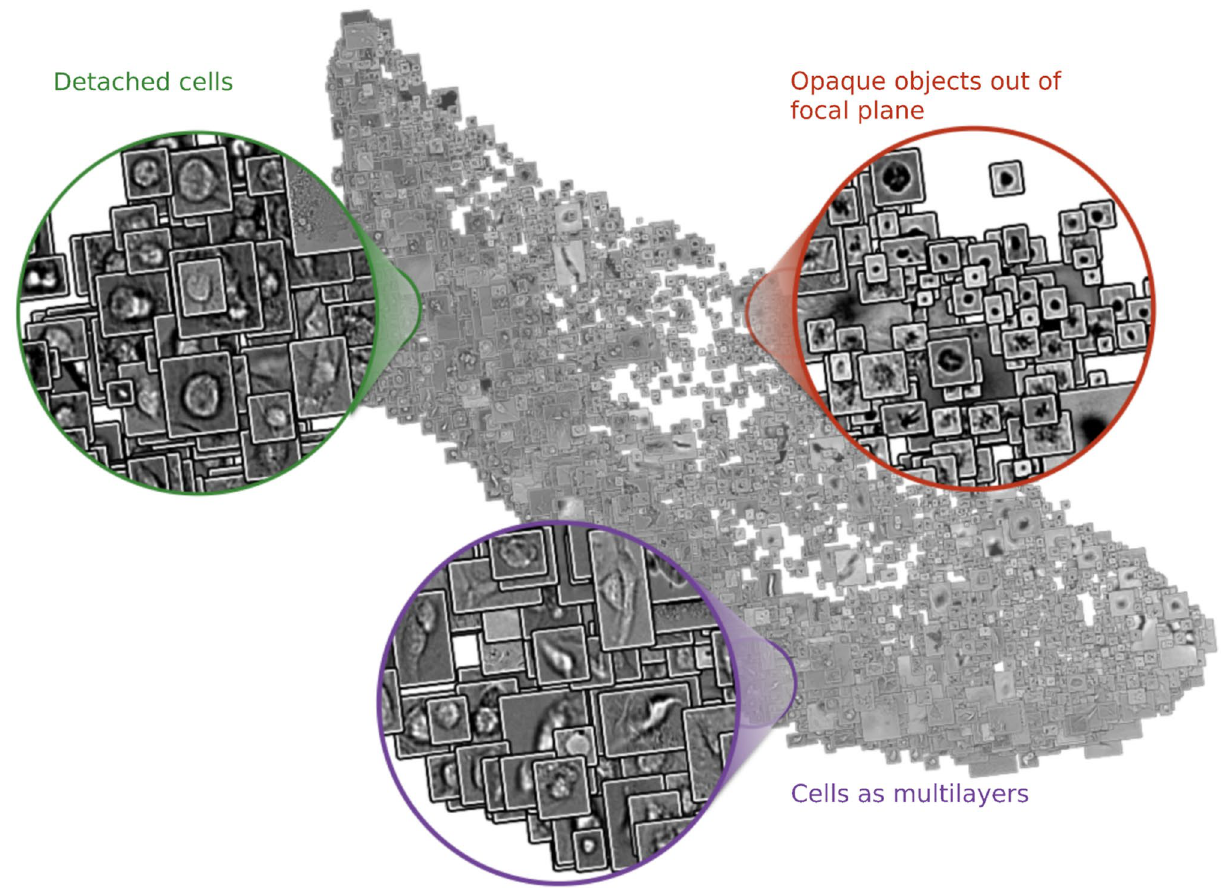
Figure 2. Artifacts are heterogeneous, and range in shapes and sizes. A UMAP projection of all artifacts from the seven cell lines dataset. The inputs to the UMAP are the pixels of each patch that contains an artifact and the outputs are the first two features in the UMAP embeddings of each patch. We then used these two features respectively as ‘x’ and ‘y’ values to plot the corresponding input patch in 2D only 2 s to point out if a given image contained an artifact. Hence, weakly supervised methods consume about two orders of magnitude less of expert time for the given case. Therefore, when making a choice of method for dealing with artifacts, it is reasonable to take into account the dataset size and the amount of time needed to produce relevant annotations. For complex projects which require large training datasets for model development, generating precise pixel-level labels is prohibitively time-consuming, and hence weakly supervised approaches like ScoreCAM-U-Net are the best automated option available. Weakly supervised artifact removal improves downstream analysis. After establishing the qual- ity of the proposed ScoreCAM-U-Net method for artifact detection and segmentation, we evaluated the impact of using it for cleaning images on two downstream applications. Removing artifacts improves quality of nuclei segmentation. As artifacts distort pixels that otherwise represent nuclei (Fig. 4), we observed substantial degradation in nuclei segmentation performance due to artifacts. The pixel-wise F1 score decreased from 0.89 in artifact-free to 0.60 in artifactual regions; and the object-wise F1 score decreased from 0.65 in artifact-free to 0.28 in artifactual regions (Fig. 5). This had a direct impact on naive analyses that do not differentiate between artifactual and clean regions, reducing segmentation accuracy (0.87 pixel-wise F1, 0.61 object-wise F1; Fig. 5). Importantly, automatically removing artifacts using ScoreCAM-U- Net has the same impact as manual removal, improving the segmentation performance to near-optimal 0.89 and 0.64 pixel-wise and object-wise F1 scores (Fig. 5). We next considered nuclear size and morphology metrics with and without artifact correction. Nuclei in areas containing artifacts show different morphological properties with nuclei solidity of 0.92 and size of 213 pixels while the same properties are 0.95 and 400 pixels respectively in the artifact-free regions (Supplementary Fig. S6). In concordance with the segmentation results, automatically removing artifacts using ScoreCAM-U- Net recovers the expected nuclei size and solidity of 397 pixels and 0.95 respectively for artifact-free areas, again performing close to the gold standard of manual removal (Supplementary Fig. S6). These results demonstrate that automatic removal can overcome the detrimental effect of artifacts with quality close to manual filtering.